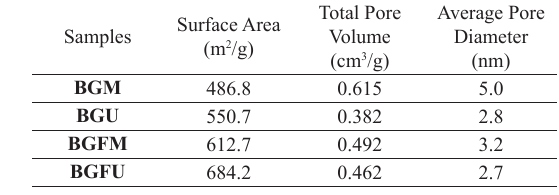
Table 4. Characterization summary obtained from nitrogen sorption isotherms of bioactive glasses.